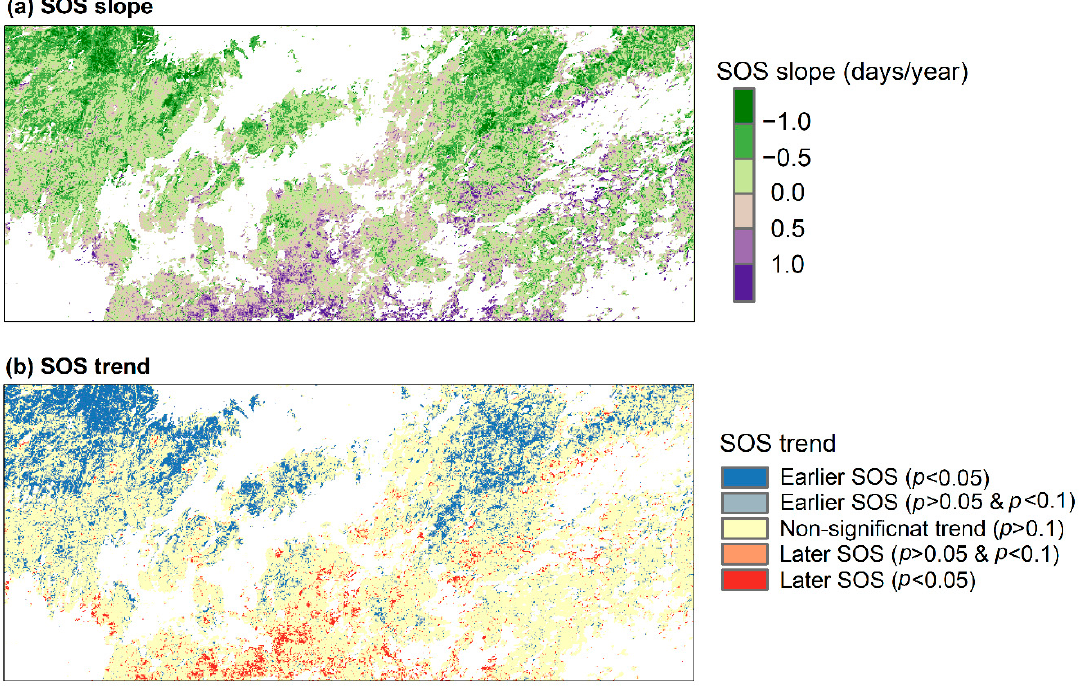
Figure 6. Spatial patterns of SOS slope ( a ) and trend ( b ) during 1999–2019 over the Nanling Moun- tains. Table 1. Proportions of SOS trends for different forest types. EBF, evergreen broadleaf forests; MF, mixed forests; OF, open forests.